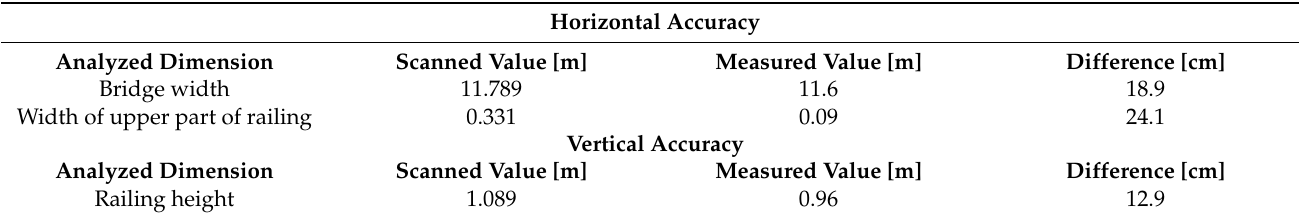
Table 4. Comparison of bridge dimensions obtained from scanned point cloud and from real measurement.